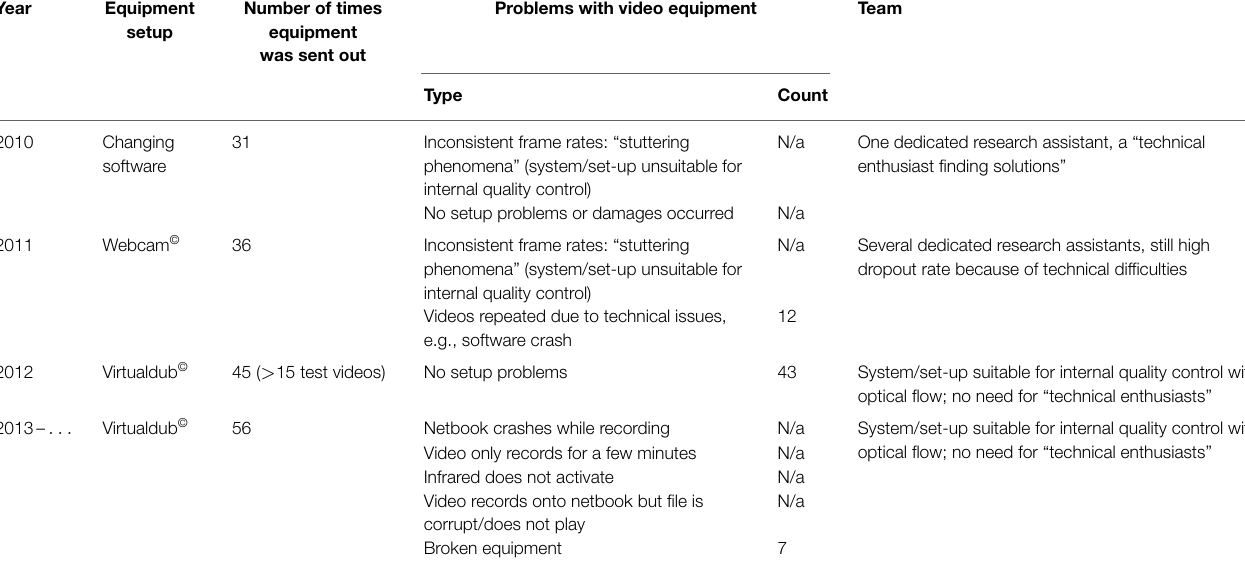
TABLE 4 | Overview of problems